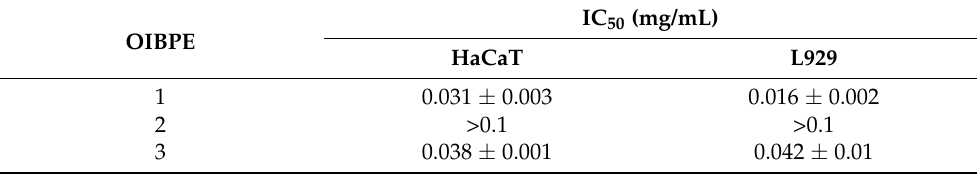
Table 3. IC 50 * values of olive oil industry by-products extracts in two cell lines.